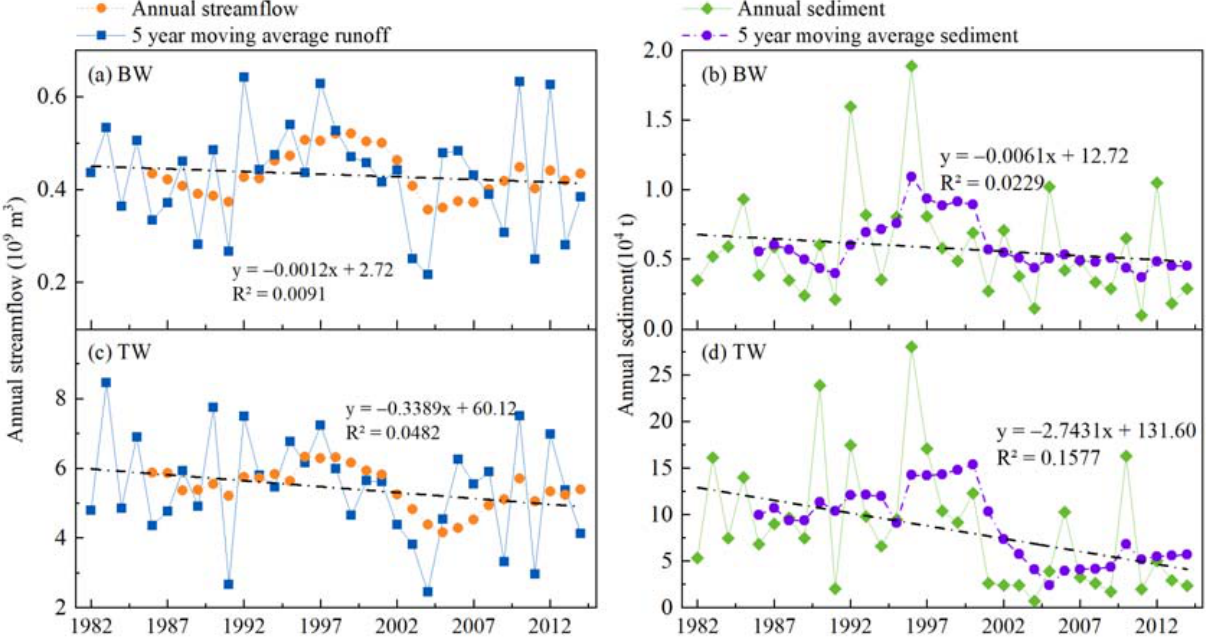
Figure 3. Annual streamflow and sediment yields at Guanyinqiao ( a , b ) and Shanghang station ( c , d ) from 1982 to 2014. Table 1. The MK trend test results of the annual precipitation, streamflow, and sediment. Watershed